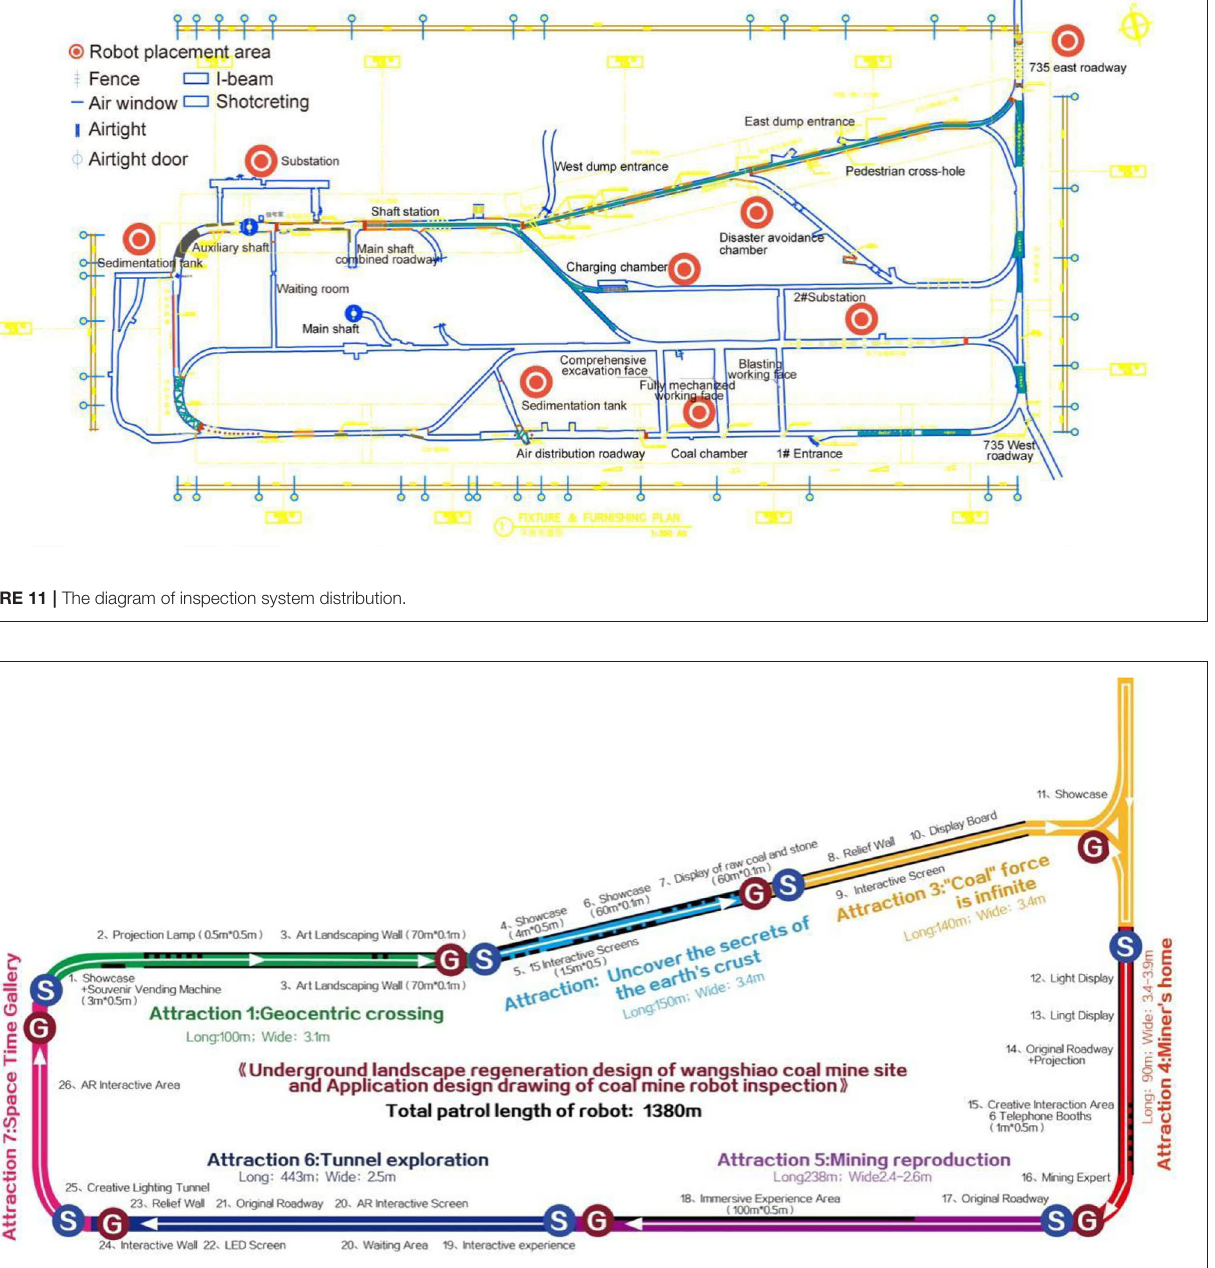
FIGURE 12 | Motion trajectory of inspection